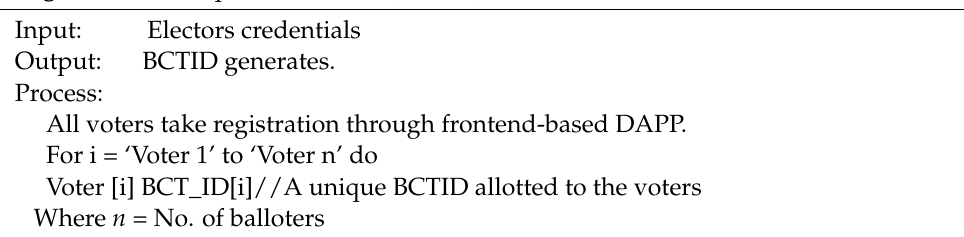
Algorithm 2: Unique ID Creation (BCTID) for Voter